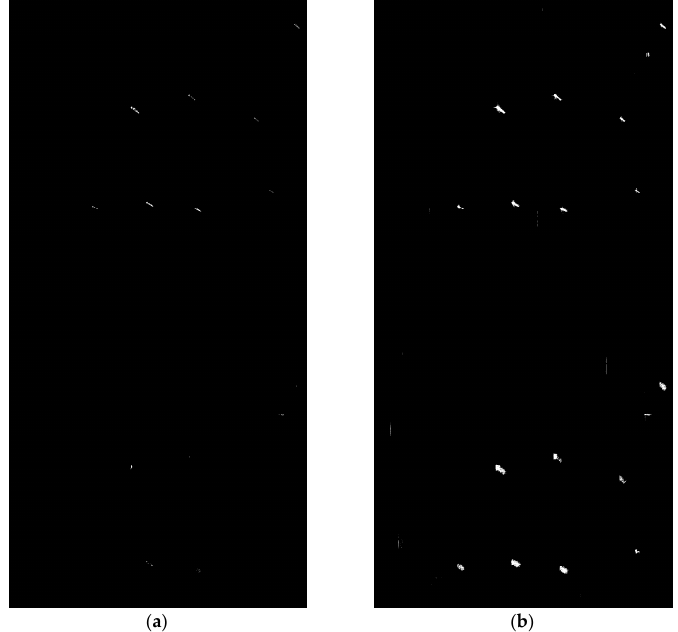
Figure 3. Detected results of the iterative CFAR approach after the first and the fourth iteration. ( a ) Detected result after the first iteration; ( b ) Detected result after the fourth iteration, the approach converges after four iterations, therefore it is also the final detected result of the iterative CFAR